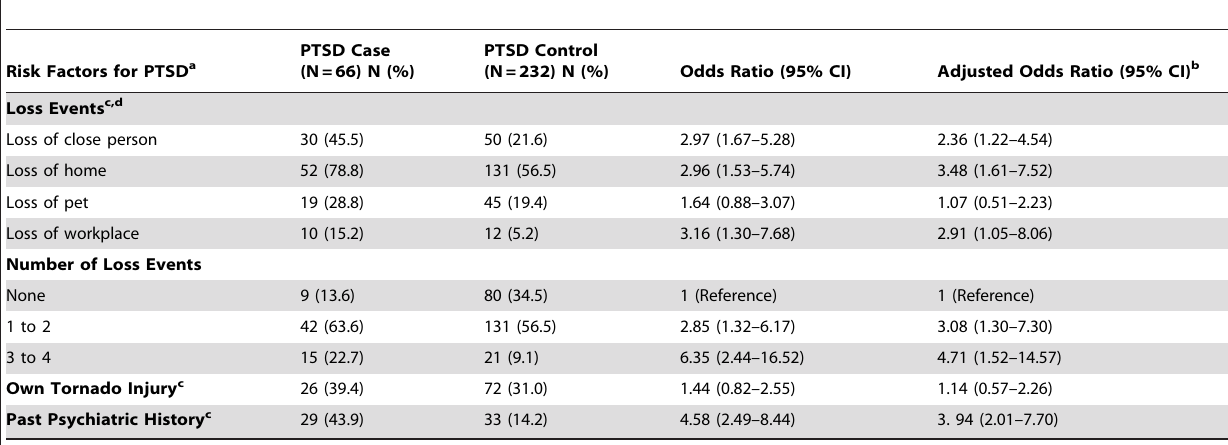
a PTSD screening based on Breslau’s Short Screening Scale for PTSD (7 dichotomous items); 4 points was the cut-off used for presence of PTSD. b Loss events, and number of loss events adjusted for age, race, sex, own tornado injury and past psychiatric history; own tornado injury adjusted for age, sex, race, number of loss events and past psychiatric history; past psychiatric history adjusted for age, sex, race, number of loss events, and own tornado injury. c Reference category is answer ‘‘no’’ to respective